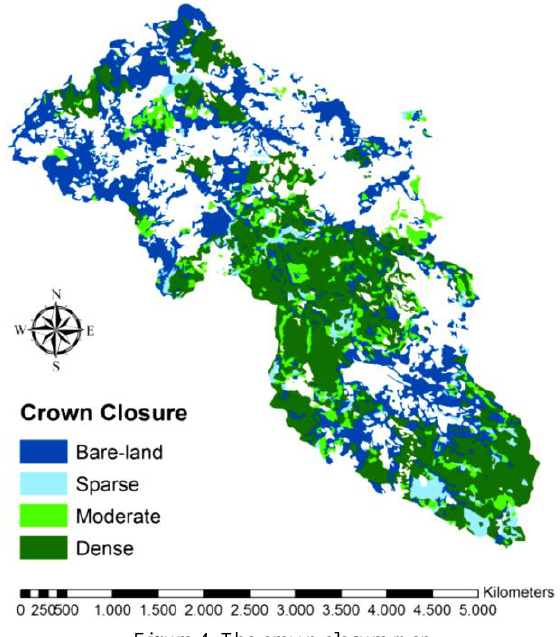
Figure 5. Ground slope map